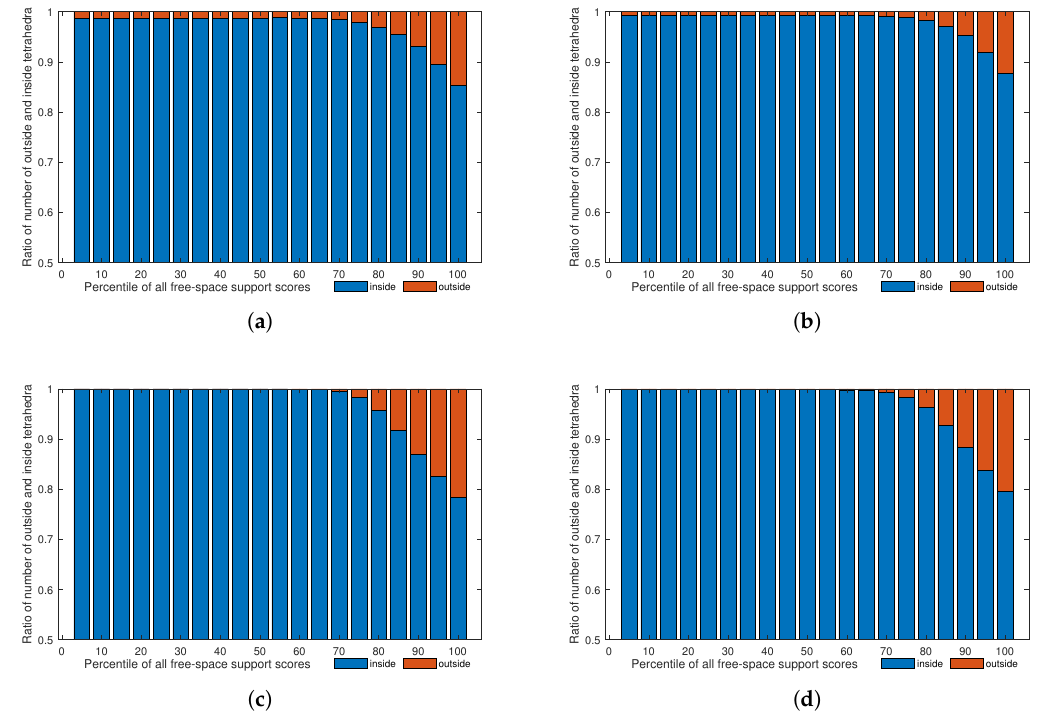
Figure 6. Free-space support analysis. The four graphs show the ratios of number of outside and inside tetrahedra in different percentiles of all free-space support scores. The four datasets are: